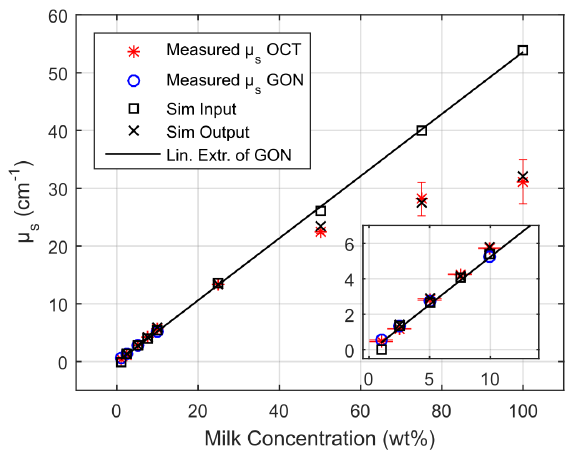
Figure 30. Comparison of µ s obtained from goniometer (GON) measurements, simulation input data linearly extrapolated from these measurements (Sim input, µ lin s ), simulation results (Sim output, µ sim s ) and OCT measurements ( µ OCT s ). The black line marks linear extrapolation from the goniometer measurements. Details of the data for low milk concentration are presented in the inset (reproduced with permission from